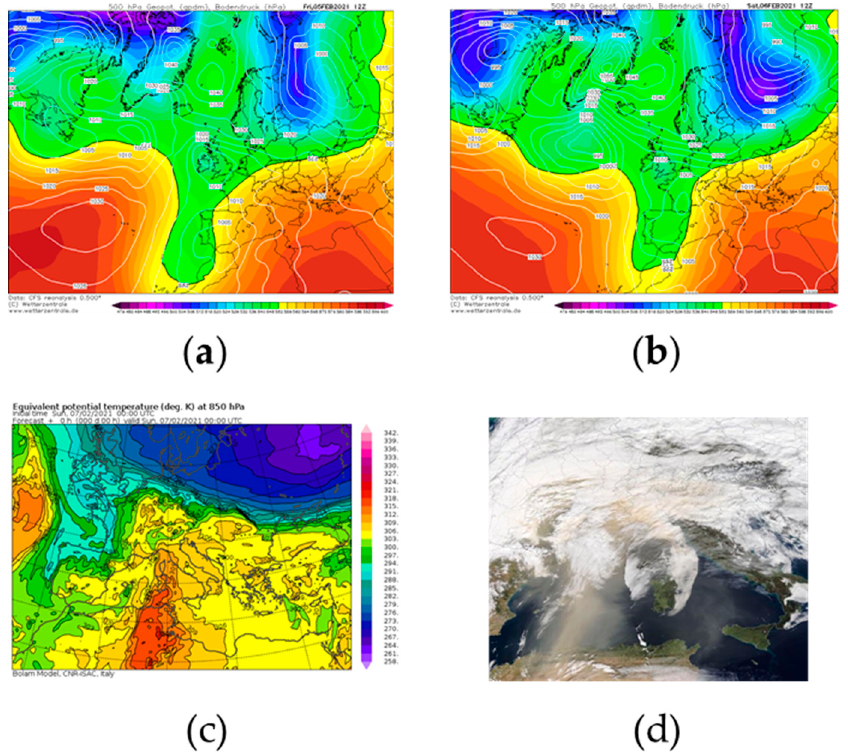
Figure 11. ( a ) Geopotential height at 500 hPa (shaded color) and sea level pressure (white solid line) fields at 12:00 UTC of 5 February 2021. ( b ) Geopotential height at 500 hPa (shaded color) and sea level pressure (white solid line) fields at 12:00 UTC 6 February 2021. Both fields were retrieved from Climate Forecast System Renalysis of National Centers for Environmental Prediction. ( c ) 850 mb equivalent potential temperature (shaded color) at 00:00 UTC 7 February 2021 from the BOLAM model of the Institute of Atmospheric Science and Climate of the Italian National Research Council.